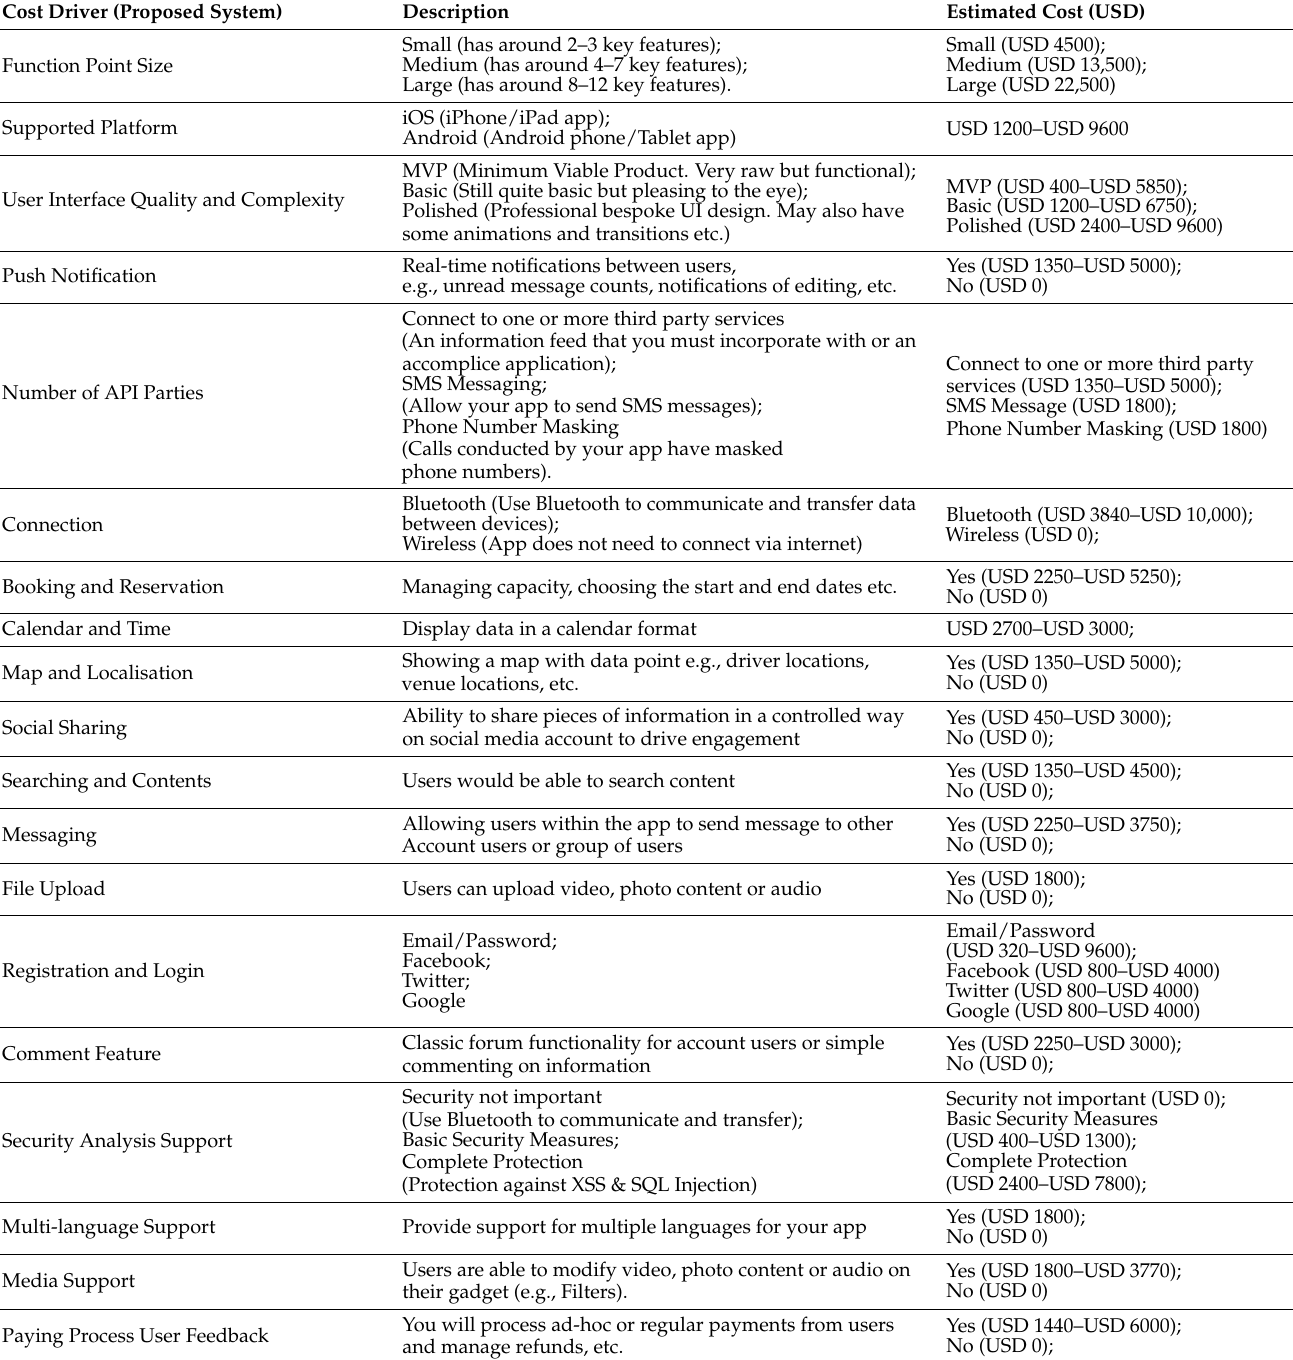
Table 2. Cost driver in proposed